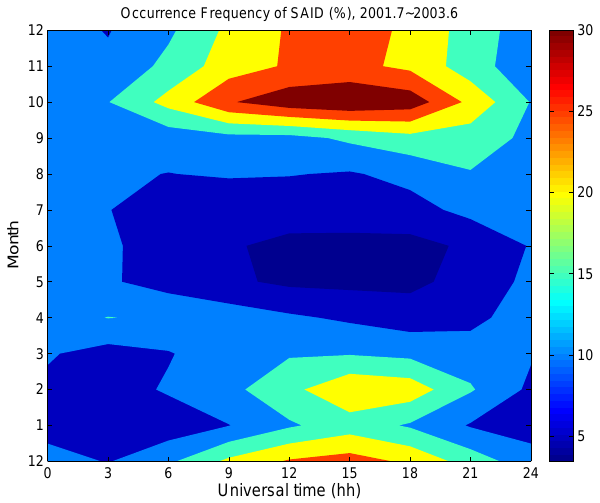
Fig. 1. Contour plot of the seasonal variation of the occurrence of SAID-type SAPS versus UT hours during the observed two years’ period. Color code reflects the probability in percent for a SAID to occur during an